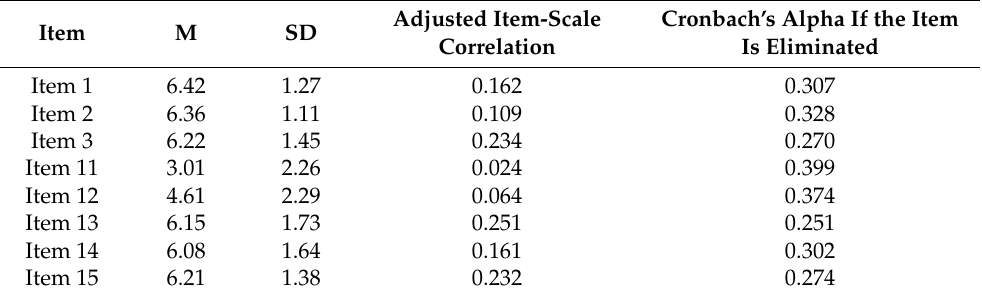
Table 7. Statistical total-item: